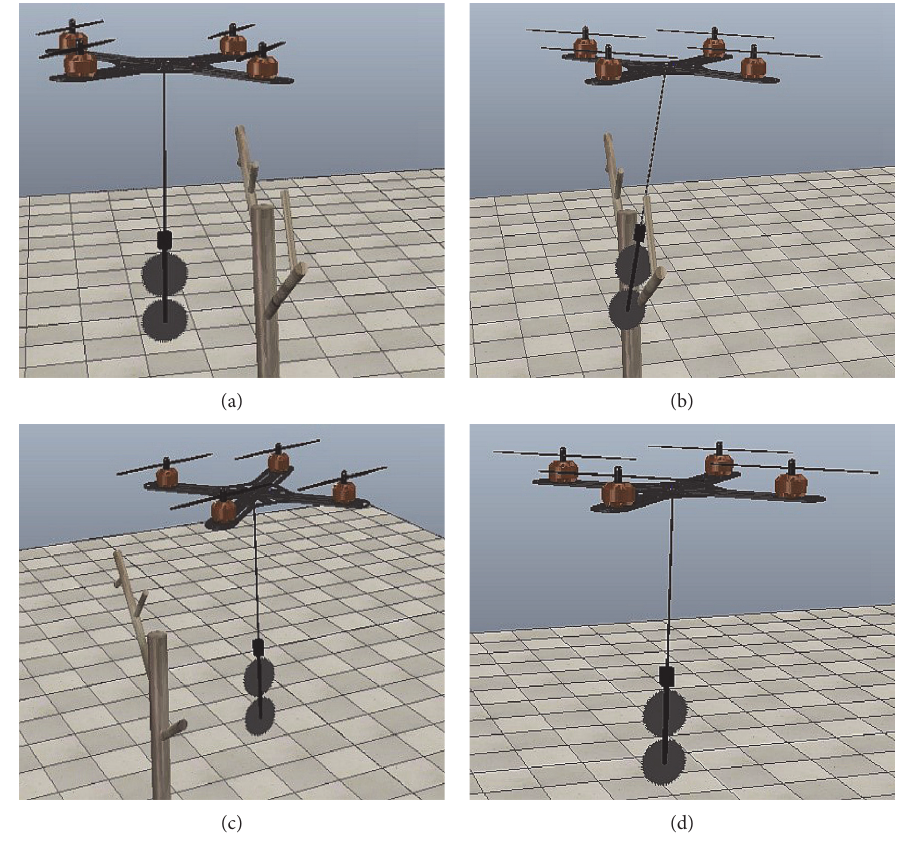
Figure 11: Snapshots of ARSS during the